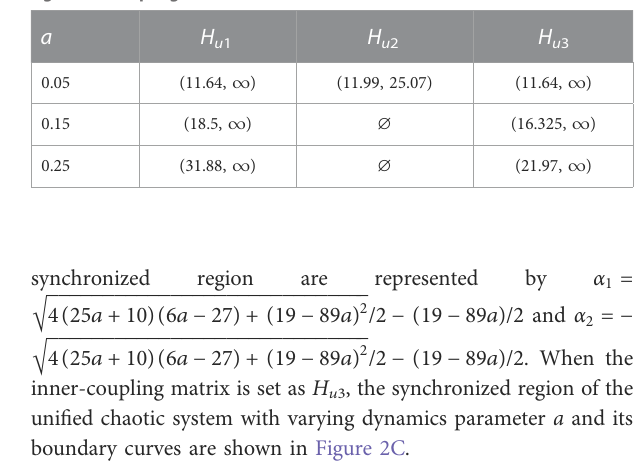
TABLE 2 Synchronized regions of the uni fi ed chaotic system under different sign inter-coupling matrices.